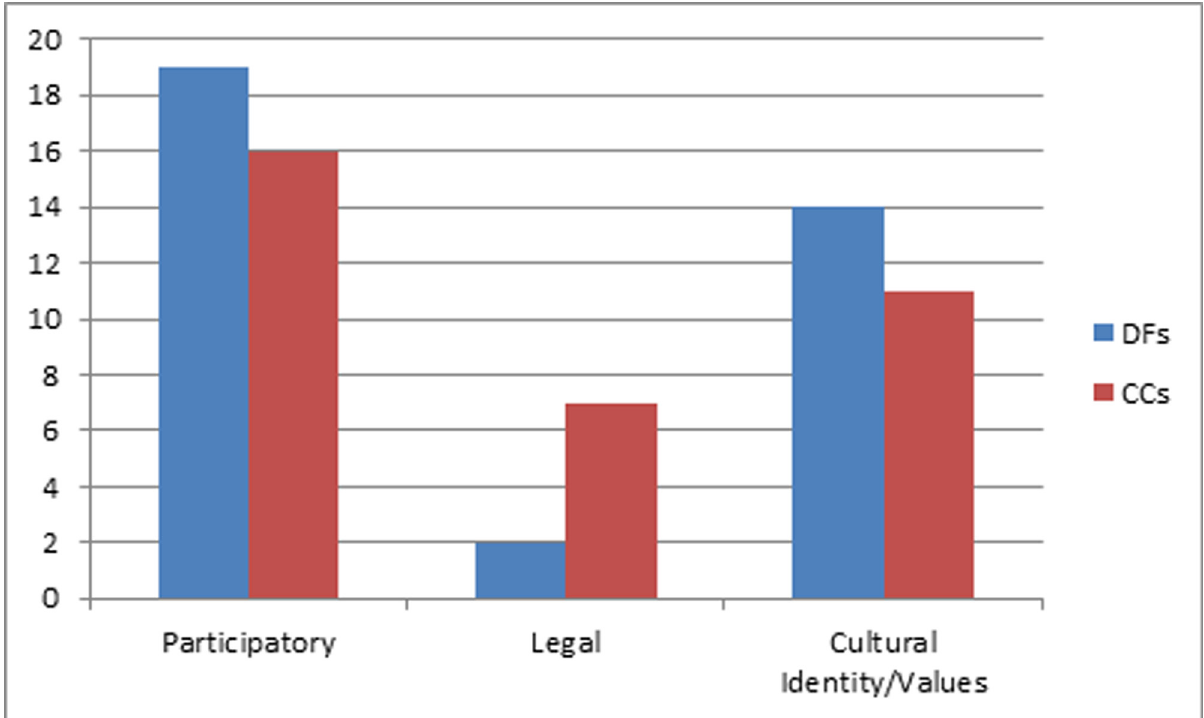
Figure 1: Number of Response Indicating Different Conceptions of Citizenship among DFs and